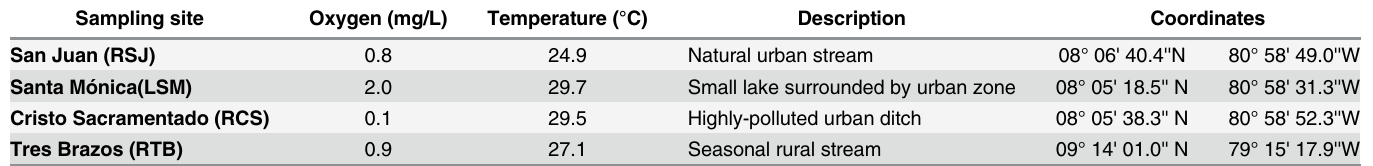
Table 1. Environmental and geographic parameters of the sampling sites in